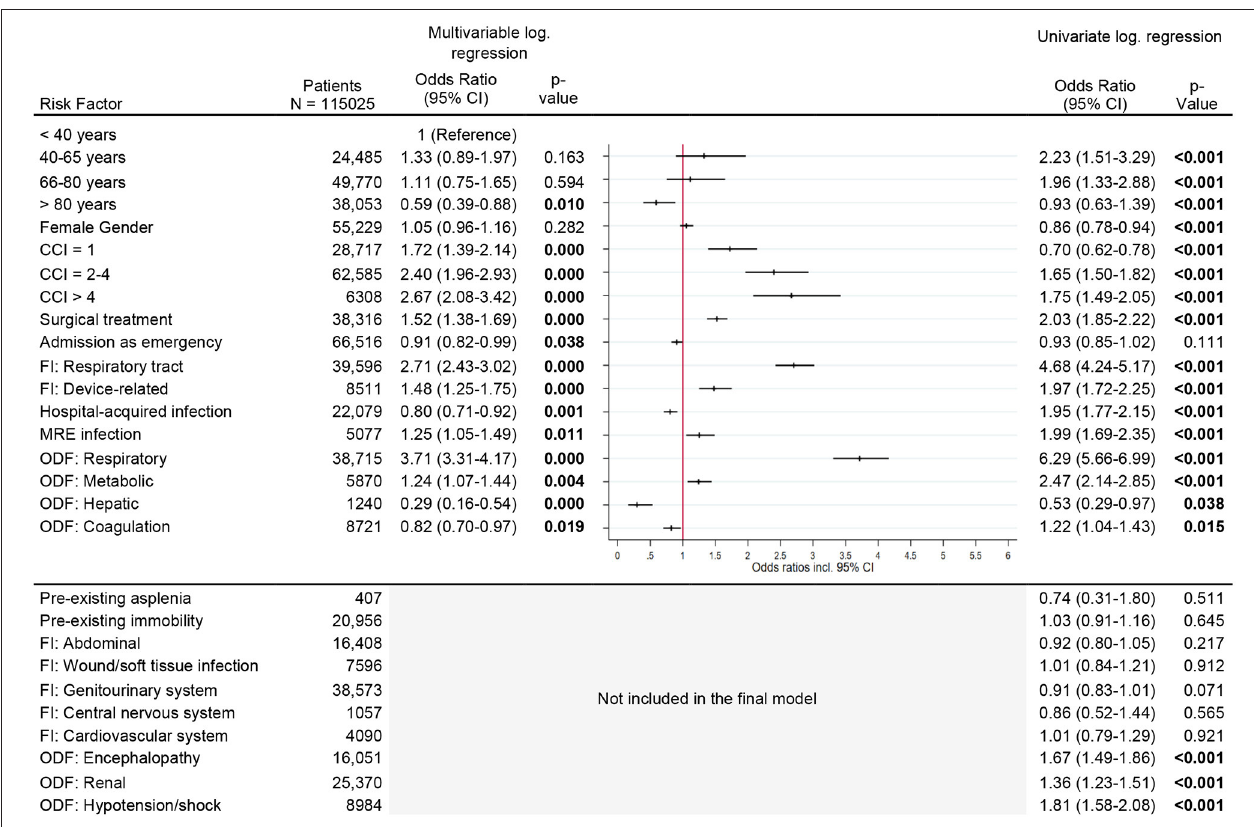
FIGURE 4 | Risk factors for new respiratory support. Legend: CCI, Charlson Comorbidity Index; FI, Focus of infection; MR, Multi-resistant; ODF, Organ